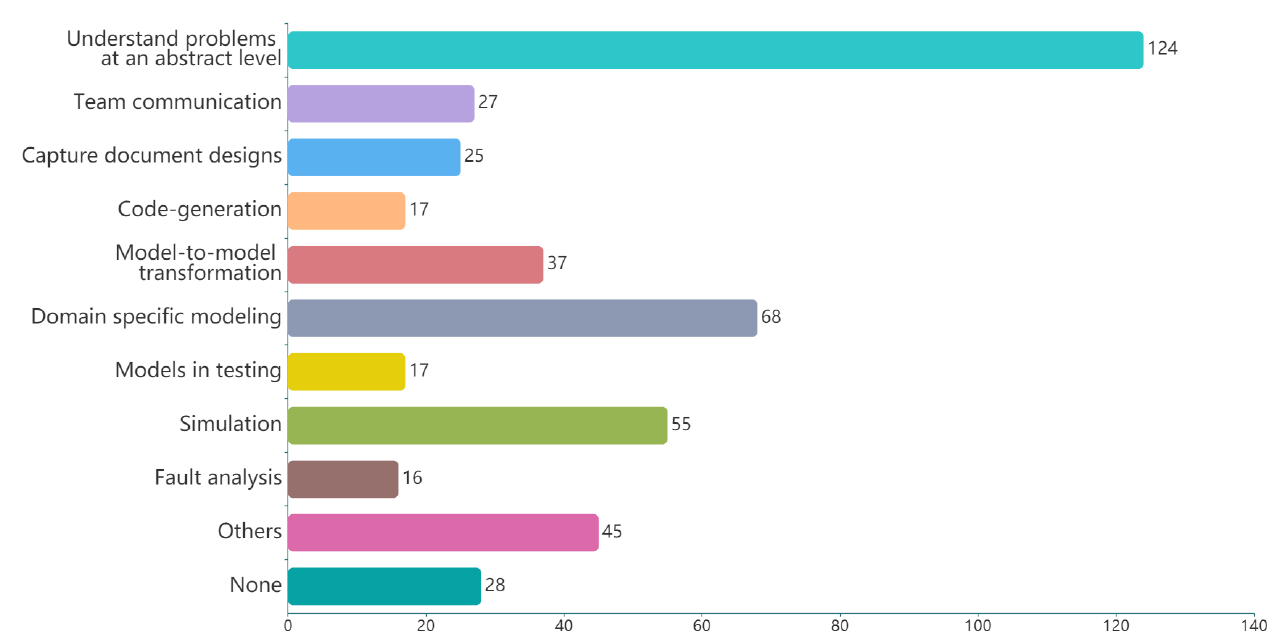
Figure 7. Modeling purposes in the